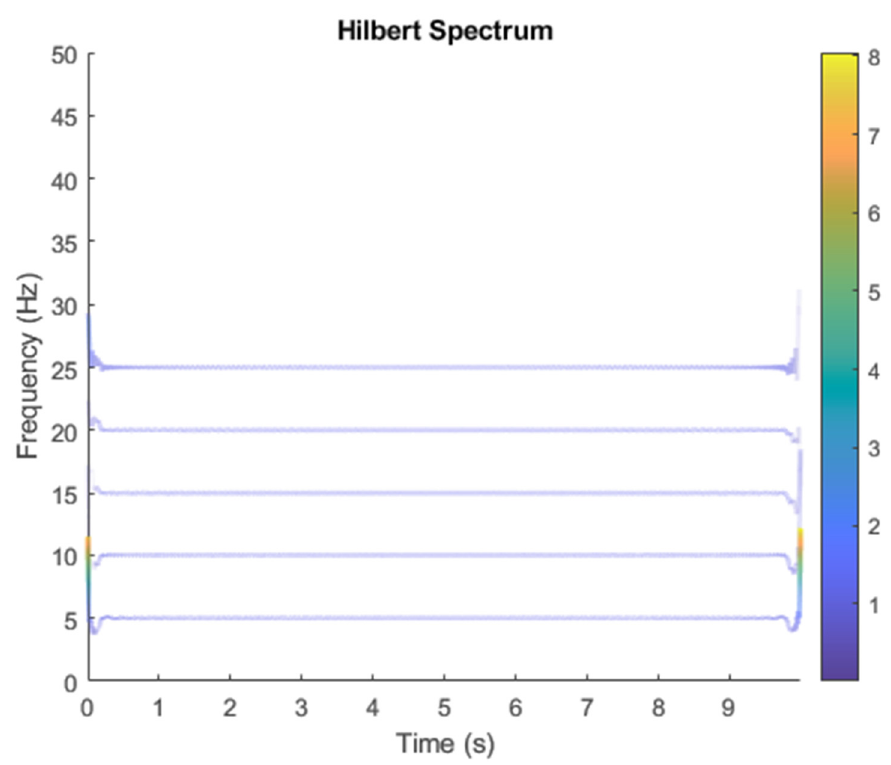
Figure 9. Analysis of original sources by Hilbert Spectrum results.